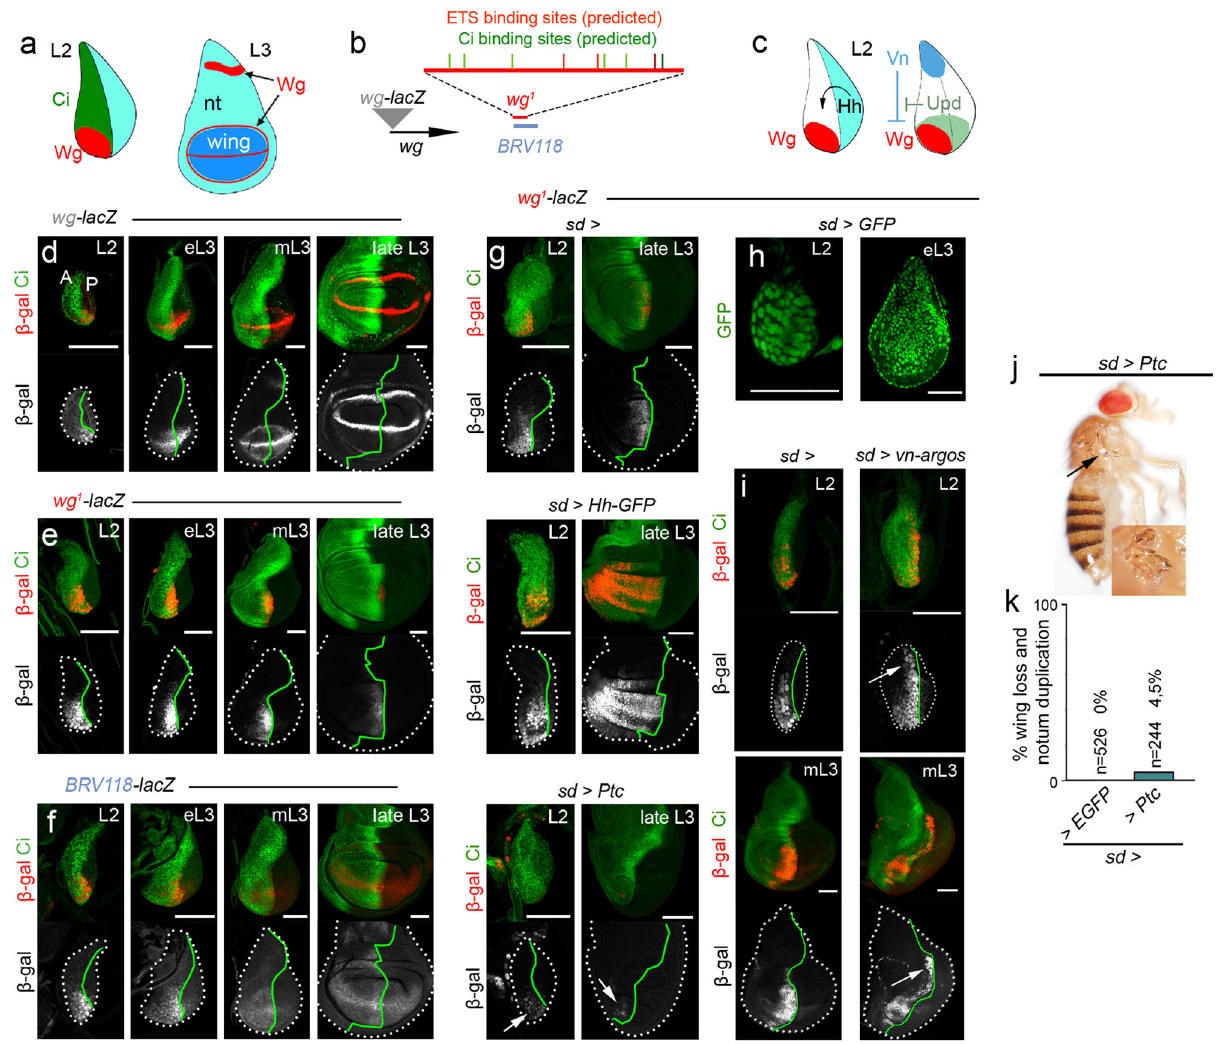
g – i , larvae expressed the indicated transgenes under the control of the sd-gal4 driver. Wing disc contour and the AP boundary are labelled by white and green lines, respectively. Arrows in g point to the presence of some lacZ-expressing cells upon Ptc-overexpression and in i to the ectopic expression of the lacZ reporters. Scale bars, 50 µ m. j Adult fl y of the indicated genotype showing the most repre- sentative phenotype: a vestigial wing (arrow, see also high magni fi cation). k Percentages of wingless fl ies of the indicated genotypes with duplicated nota. Number of scored nota are shown. See also Supplementary Figs. 2 and 3 and Supplementary Tables 1 – 4 and